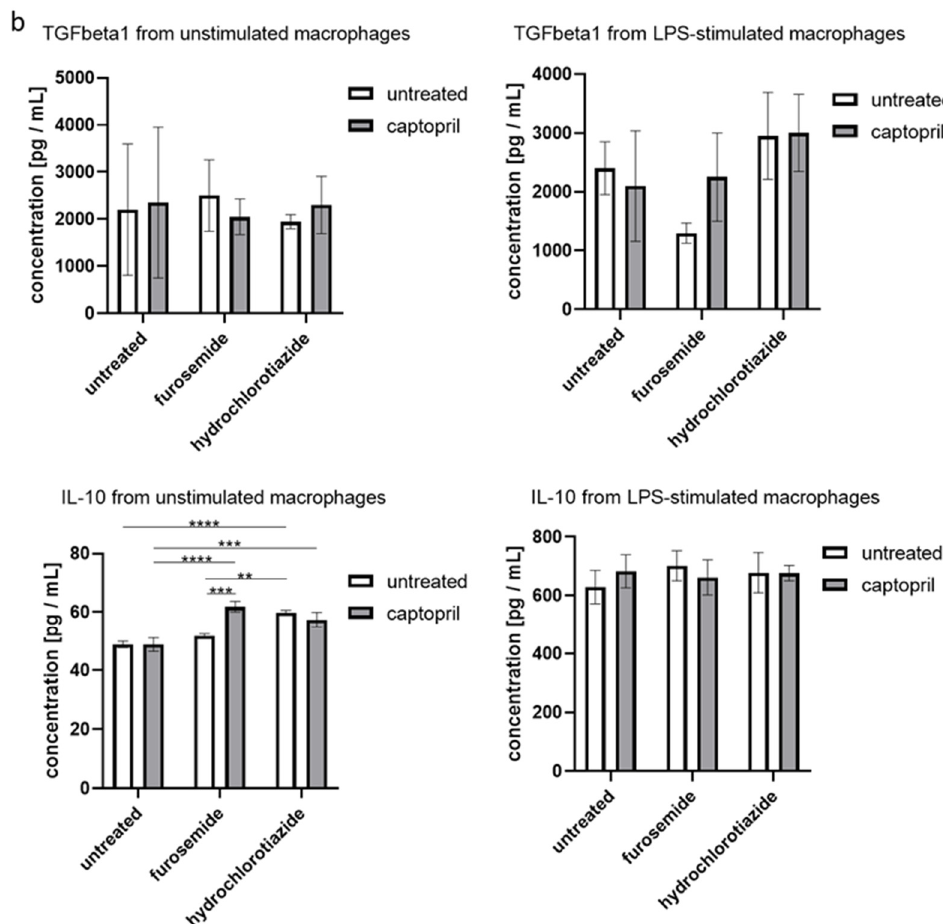
Figure 3. Captopril and diuretic drugs influence the secretion of cytokines by cultured macrophages. Oil-induced peritoneal macrophages from mice treated with captopril with or without respective diuretic drugs were cultured in standard conditions, in some cases after stimulation with LPS (200ng). Enzyme-linked immunosorbent assay (ELISA) was used to measure ( a ) the concentration of IL-6, and TNF α in supernatants collected after 24h of culture and ( b ) the concentration of IL-10 and TGF- β 1 in supernatants collected after 48h of culture. Concentrations were expressed as mean (+/ − SD) per group. Two-way ANOVA with Tukey post hoc test. * p < 0.05; ** p < 0.01; *** p < 0.005; **** p < 0.001.